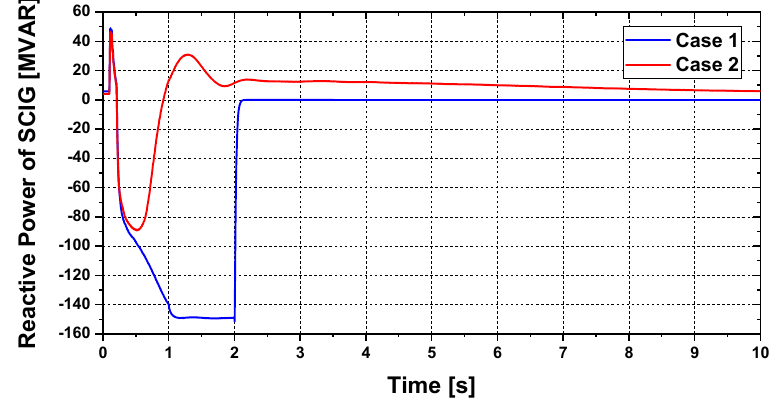
Electronics 2020 , 9 , 239 Figure 12. Reactive power response of SCIG. Figure 12. Reactive power response of SCIG. Figure 12. Reactive power response of SCIG.